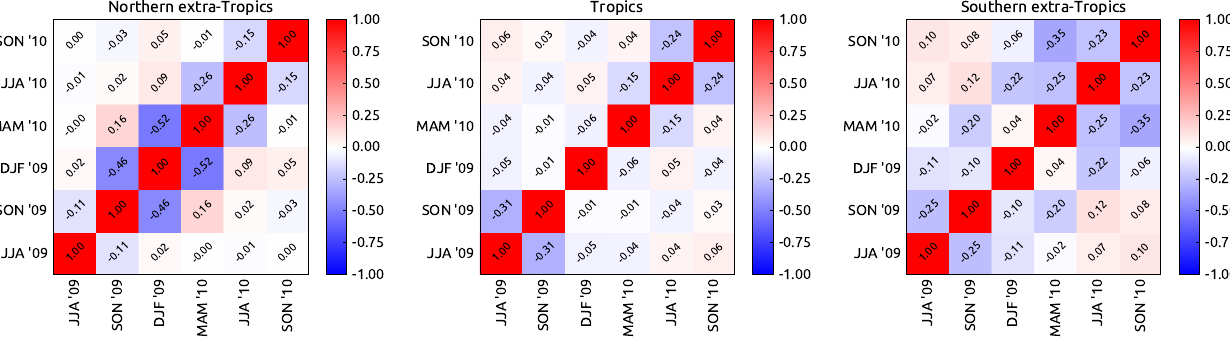
Fig. 11. The posterior temporal correlation between the flux adjustments made in different seasons for the three latitudinal bands represented in Fig. 10. The numbers in the cells are the posterior correlation